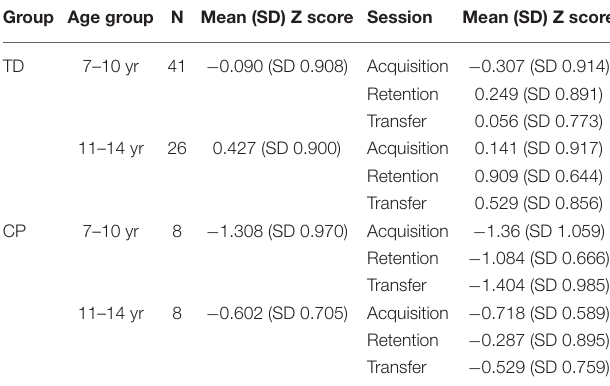
models show that the R 2 almost doubles ( R 2 = 0.304 vs. R 2 = 0.541) when accounting for these effects of random between- child